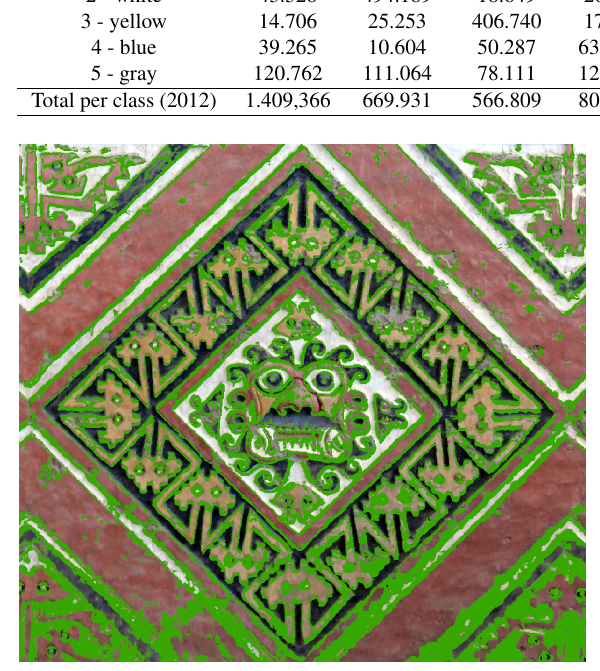
Figure 6. The hybrid classification comparison by green region map between 2006 and 2012 displayed on ortho-image.